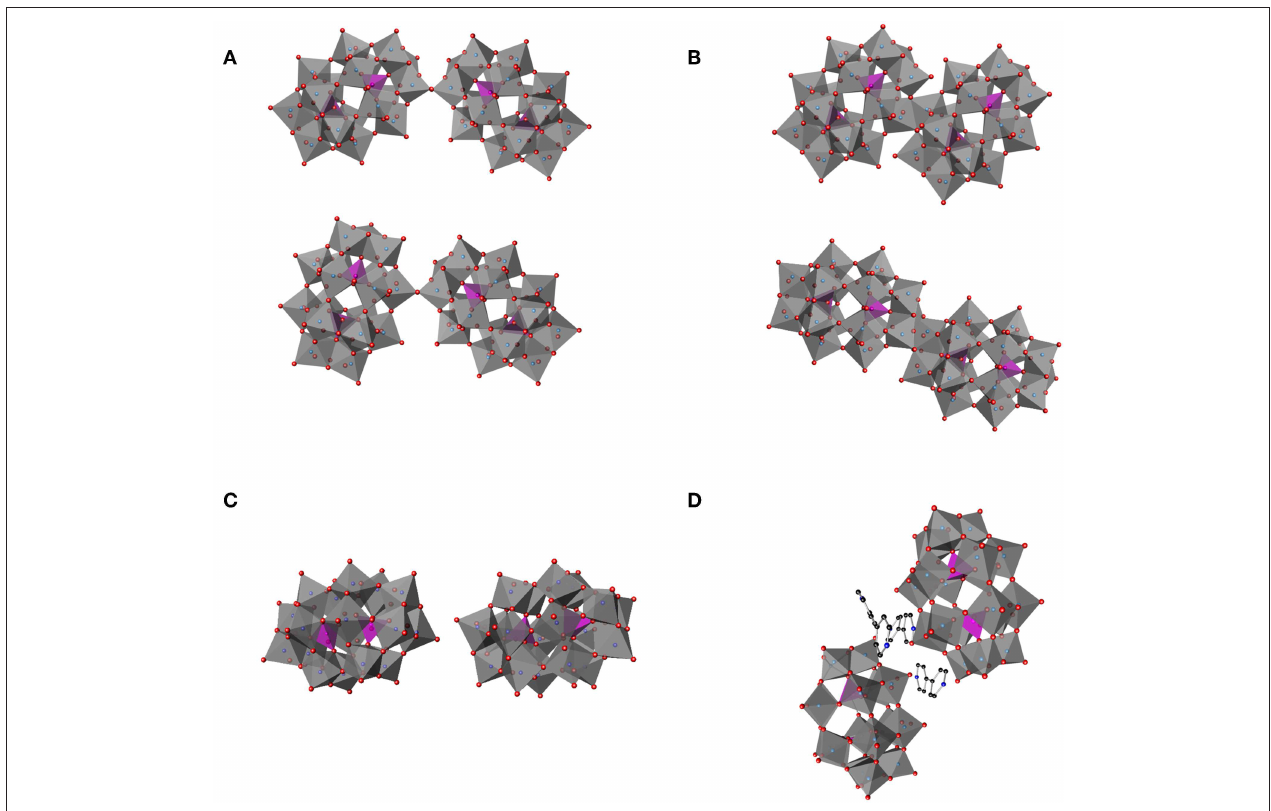
FIGURE 5 | Schematic illustration of several hypothetical double Dawson clusters. (A) Double Dawson structures may be connected through a joint oxygen atom on a corner, corner-shared (P 2 W 18 O 61 ) 2 O, in a cap-to-cap (top) or belt-to-cap (bottom). (B) Two structural possibilities where the Double Dawson structure are connected through the edge, edge-shared (P 2 W 18 O 60 ) 2 O 2 , with belt-to-belt (top) and cap-to-cap (bottom). Two full P 2 W 18 Dawson units can be interacting through (C) H-bonding (2:2 isomer) [from YEFRAF (Liu et al., 2014)] or (D) through some other linker such as 4,4 ′ -bipyridine from Zhao et al. (2008).